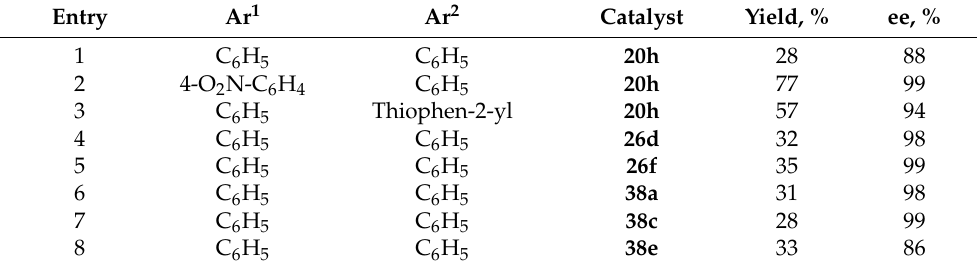
Table 6. Effect of crown ethers in the MIRC reaction of chalcones ( 49 ) and diethyl bromomalonate ( 63